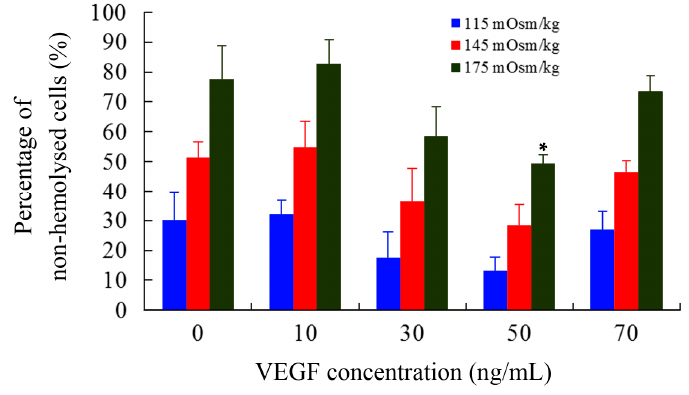
Figure 1. The hemolysis rate of mDCs treated with different concentrations of VEGF. Compared with control group, * p < 0.05.